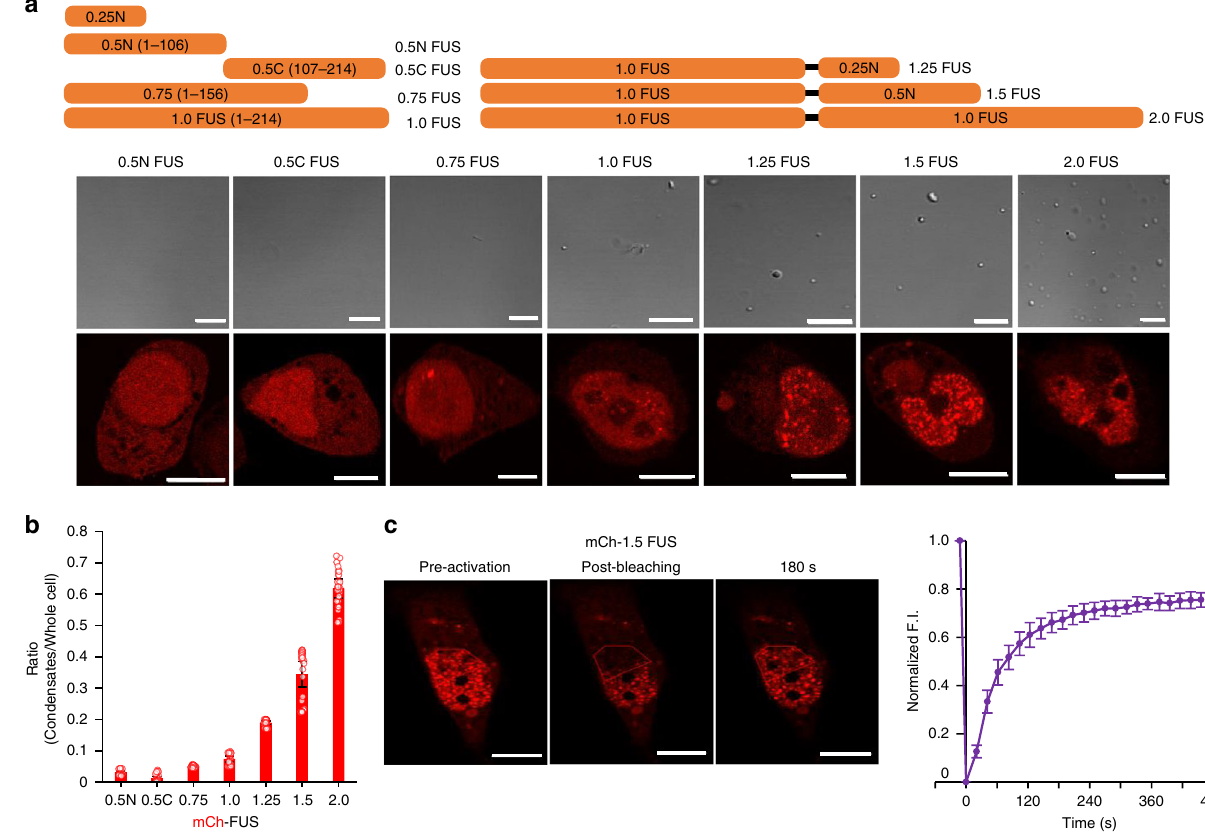
Fig. 1 Cellular compartment formation with length-varied FUS. a Protein condensate formation of mCherry (mCh)-fused FUS constructs with varied lengths in HeLa cells (bottom) or length-varied FUS in a solution (middle). Schematic diagrams of length-varied FUS constructs (sequences in Supplementary Information) are shown (top). b Total mCh intensities of condensates (puncta sizes > 0.01 μ m 2 ) divided by whole cell mCh intensities. Data are presented as mean values with ±1 SD as error bars ( n = 32 for 0.5 N, 0.5 C, 0.75, n = 31 for 1.0, 1.25, n = 33 for 1.5, 2.0 FUS; n : biologically independent cells examined over three independent experiments). c FRAP recovery images and pro fi les of scaffold proteins of mCh-1.5 FUS condensates. Data (point) are presented as mean values with ±1 SD as error bars ( n = 33 cells from three independent experiments). Scale bars: 10 μ